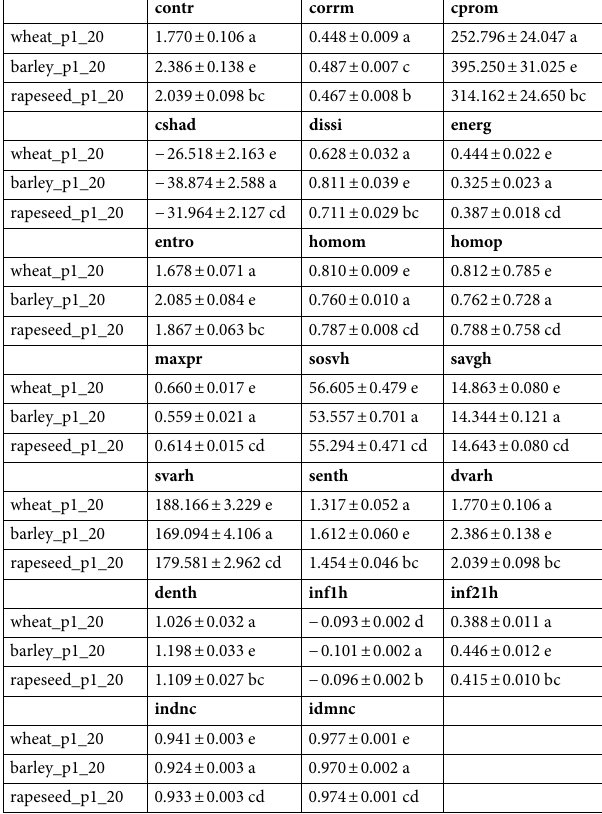
Table 4. Texture analysis of kernels for selected air stream velocities (20 m s −1 ) and the position of the seed- air tube type I. a–e: the differences between mean values with the same letter in columns were statistically insignificant ( p <